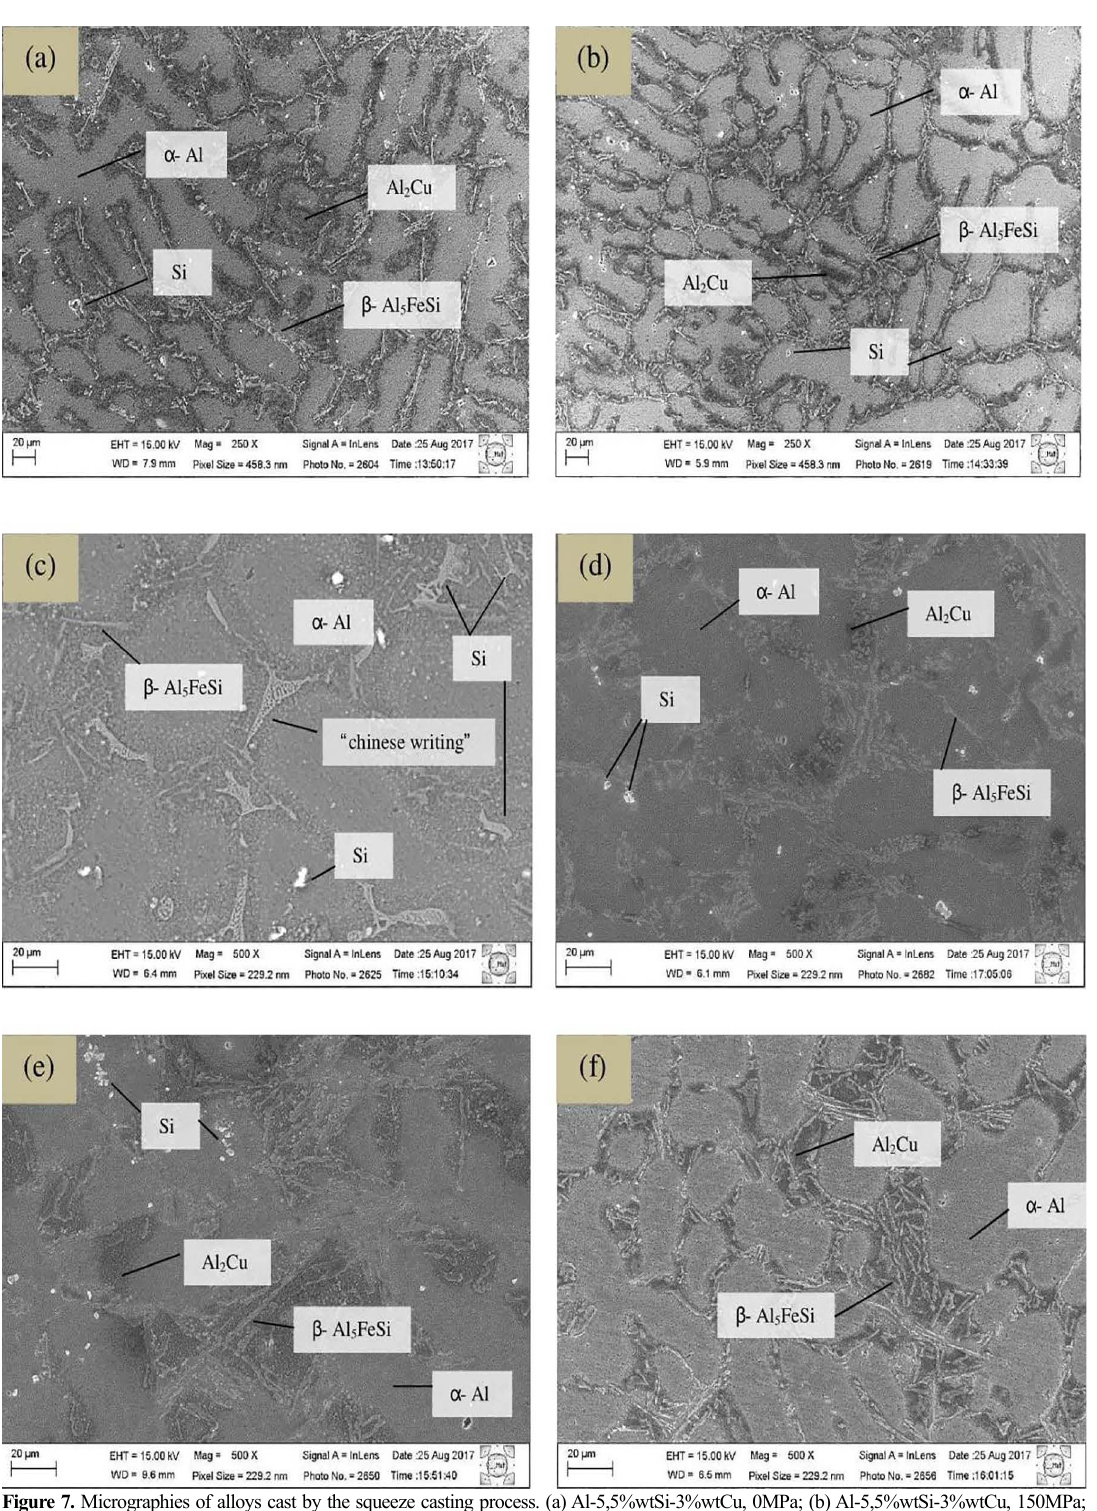
Figure 7. Micrographies of alloys cast by the squeeze casting process. (a) Al-5,5%wtSi-3%wtCu, 0MPa; (b) Al-5,5%wtSi-3%wtCu, 150MPa; (c) Al-7,5%wtSi-3%wtCu, 0MPa; (d) Al-7,5%wtSi-3%wtCu, 150MPa; (e) Al-9%wtSi-3%wtCu, 0MPa and (f) Al-9%wtSi-3%wtCu,